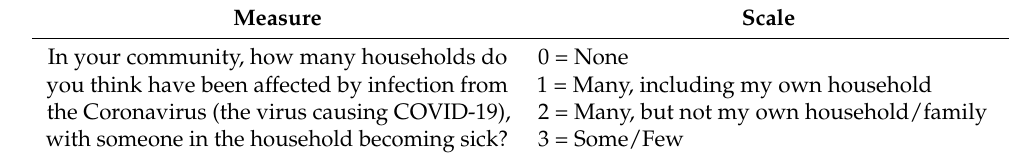
Table 2. COVID Survey